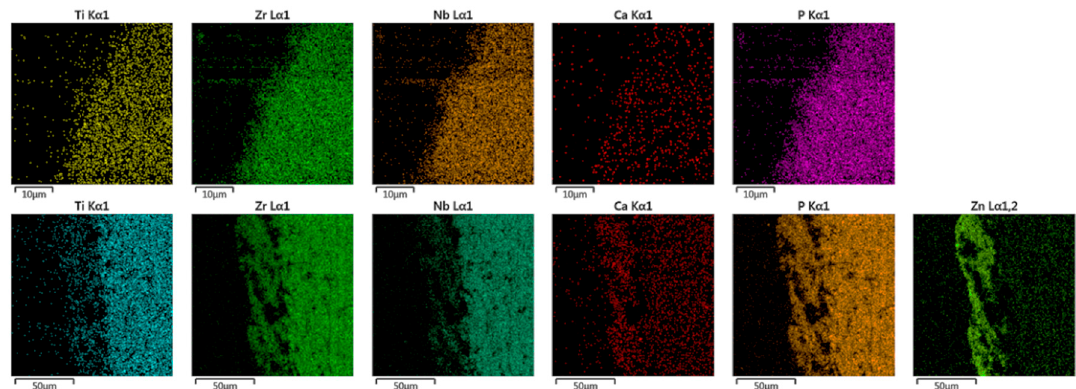
Figure 4. Exemplary EDX mapping of TiZrNb alloy cross-sections after PEO in Ca(H 2 PO 2 ) 2 electrolyte without ( upper row ) and with addition of ZnO-NPs ( low row ).